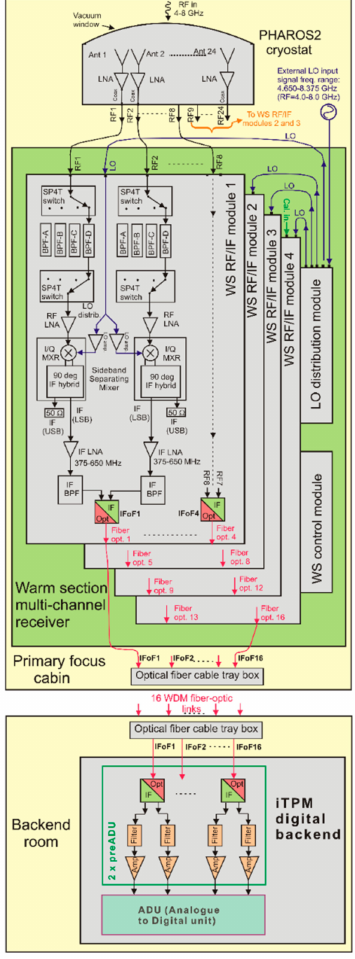
Figure 2. Block diagram of the PAF receiver chain showing the PHAROS2 cryostat (top), the Warm Section multi-channel receiver (middle) and the Italian tile processing module (iTPM) digital backend (bottom). The schematic of the Warm Section multi-channel receiver, located in the primary focus receiver room, is enclosed by the green background